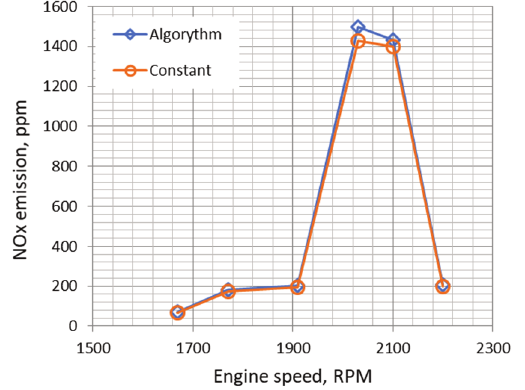
Fig. 15. Relationship between NO x emission and rotational speed for constant and variable ignition advance angle